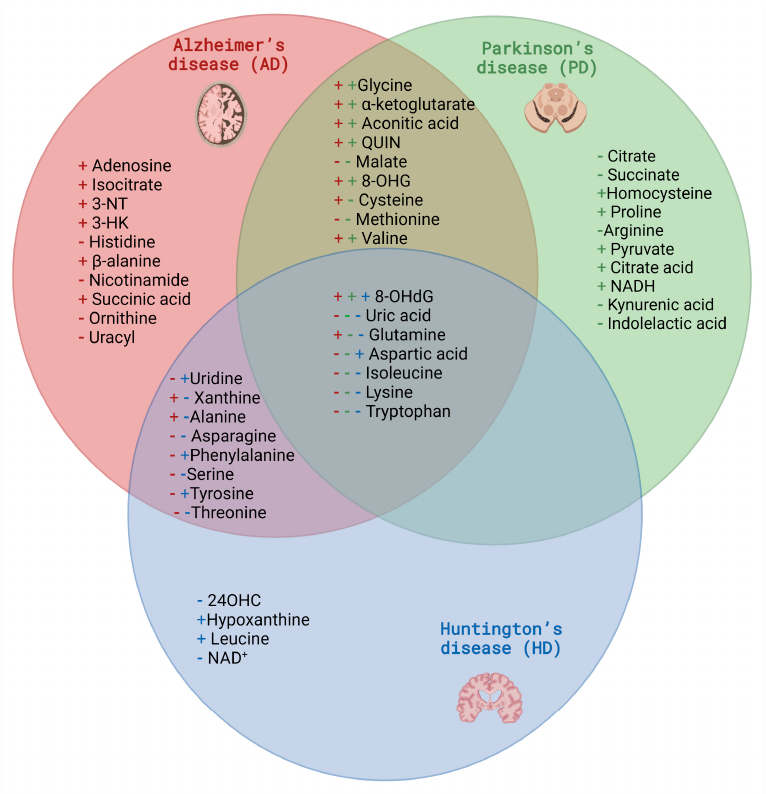
Figure 5. Comparison of disturbances in concentrations of metabolites associated with impaired energy metabolism in AD, PD, and HD.